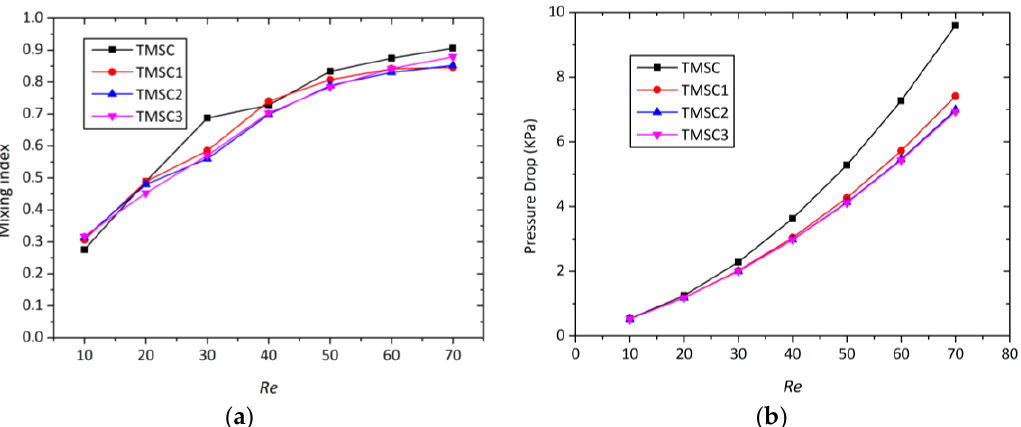
Figure 14. ( a ) Variation of mixing index of micromixer with Reynolds number; ( b ) variation of the pressure drop with Reynolds number.